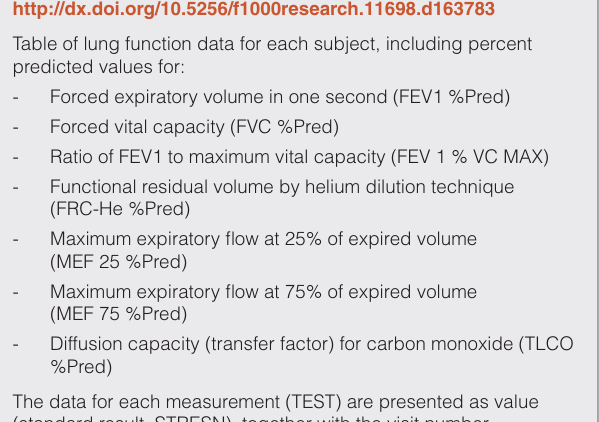
Table of body mass index, diastolic and systolic blood pressure, heart and respiration rate measures. The data for each measurement (TEST) are presented as value (standard result, STRESN) and unit (standard unit, STRESU) for each subject, and visit number (VISITNUM) at which measurements were obtained.